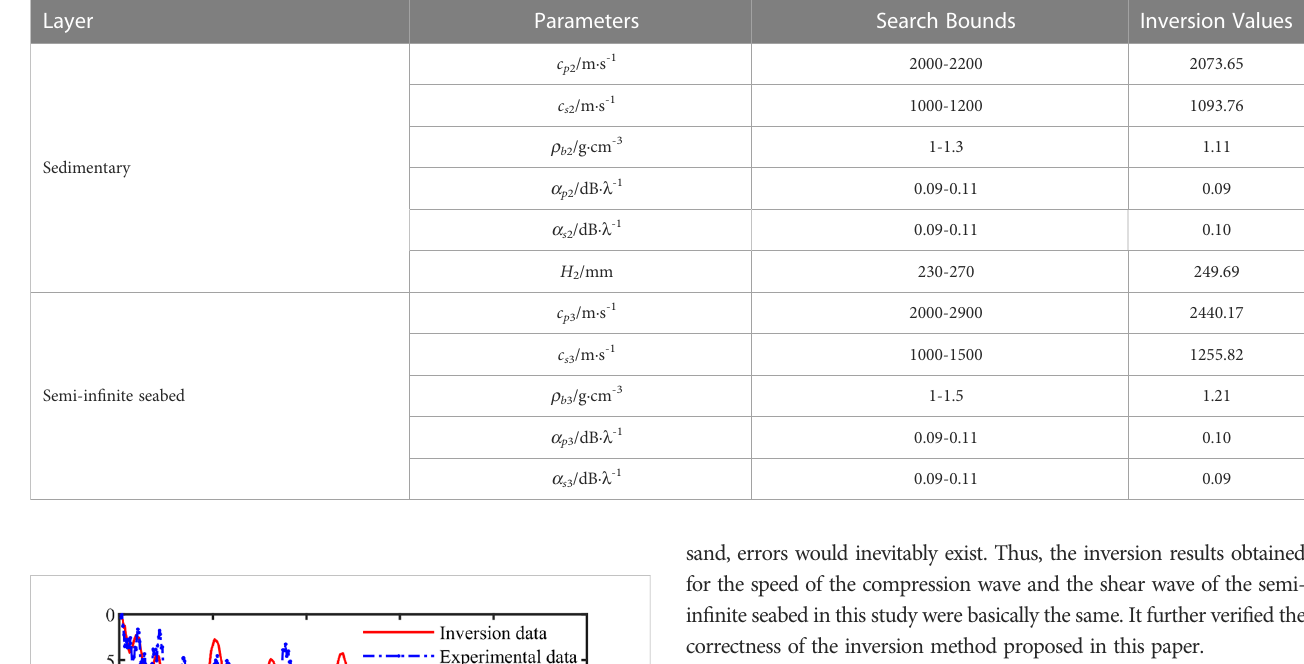
TABLE 3 Results of the measured inversion data. Layer